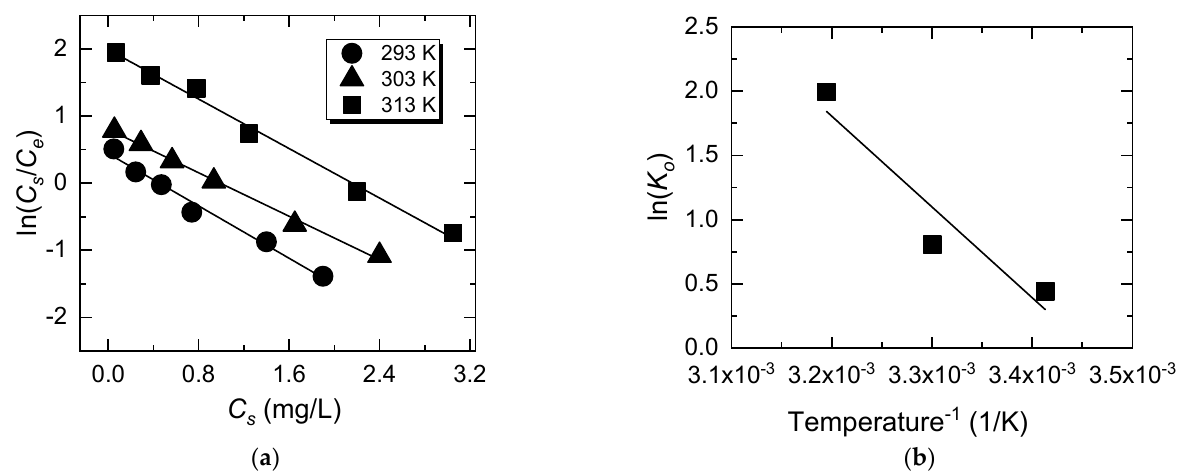
Figure 4. The fitting results of thermodynamic analysis: ( a ) plots of ln( C s /C e ) versus C s at different experimental temperatures and ( b ) ln( K 0 ) versus 1/ T .